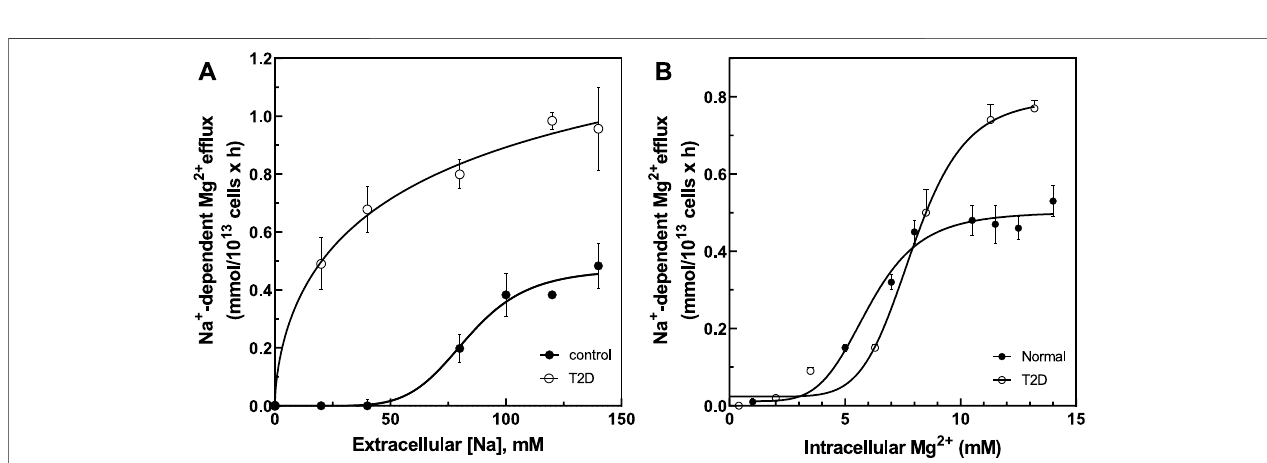
FIGURE 4 | EffectofSrcinhibitorsonNa + /Mg 2+ exchanger activityin cellsfromtype2diabeticsubjects.Cellswereincubated inglucosesolutionsof6 mM(106 mg/dl)or 50 mM(900 mg/dl),in thepresenceorabsenceof300 nMPP2asindicated,thenassayedforNa + /Mg 2+ exchangeractivity. (A) Valuesrepresentexchangeractivityincellsfrom normalsubjectsandareexpressedasmeans±SEMofthreeexperimentsintriplicatedeterminations.Non-parametricpairedttest,* p < 0.003** p < 0.002frombasalactivityofthe exchanger; (B) Values represent exchanger activity in cells from diabetic subjects and are expressed as means ± SEM of three experiments in triplicates. Non-parametric paired t test * p < 0.05, ** p < 0.05 from basal activity.